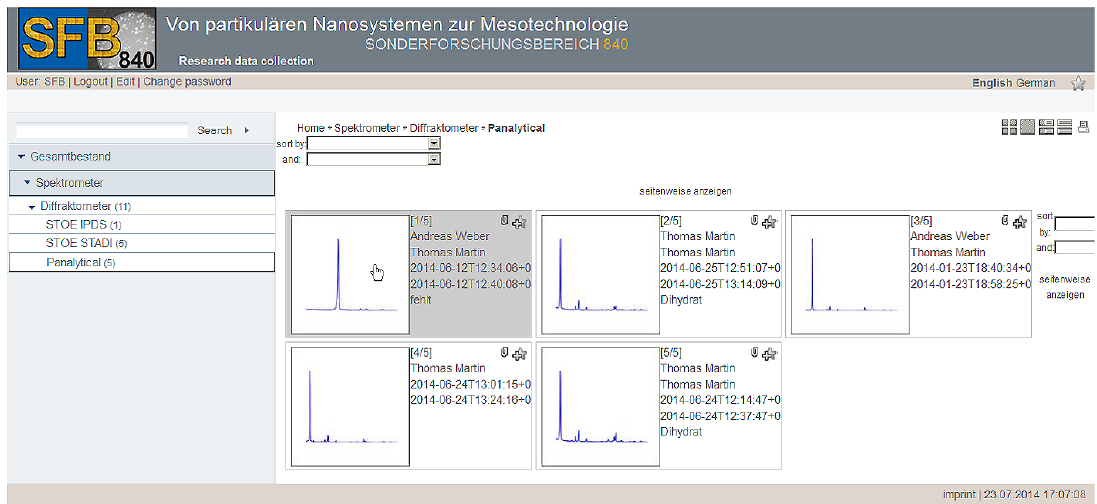
Figure 7. Presentation of Object Type “Panalytical” in the data repository.